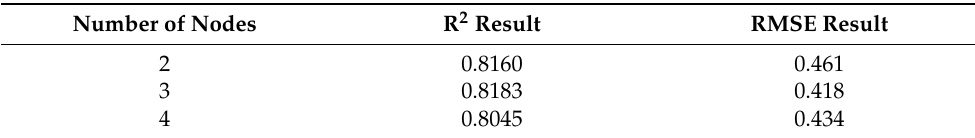
Table 7. Analysis results under different numbers of hidden nodes using BP neural network with the F 60 as the output